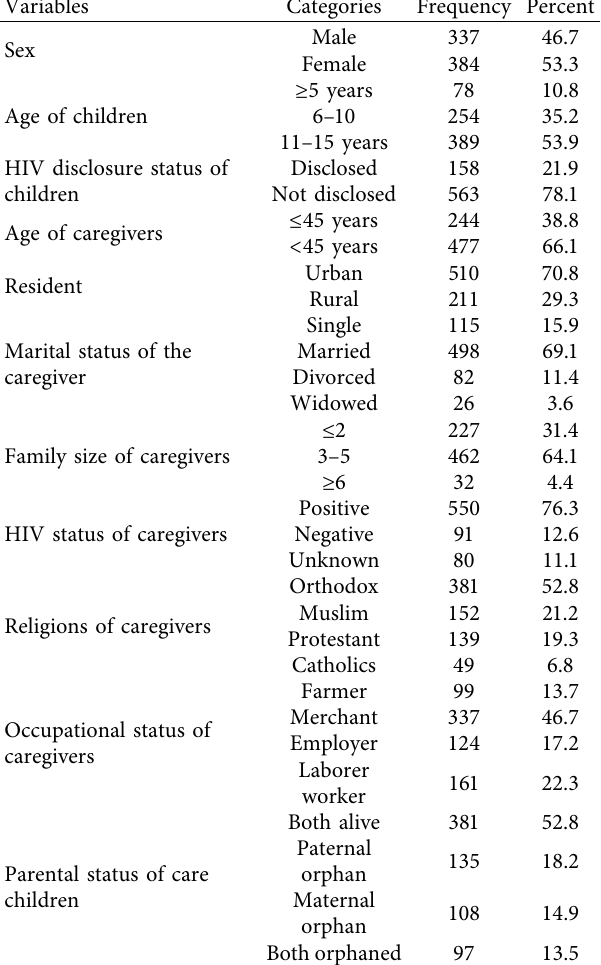
Table 1: Baseline sociodemographic characteristic of HIV positive children who received ART in selected public health facility, Northwest Ethiopia, 2020 ( N �